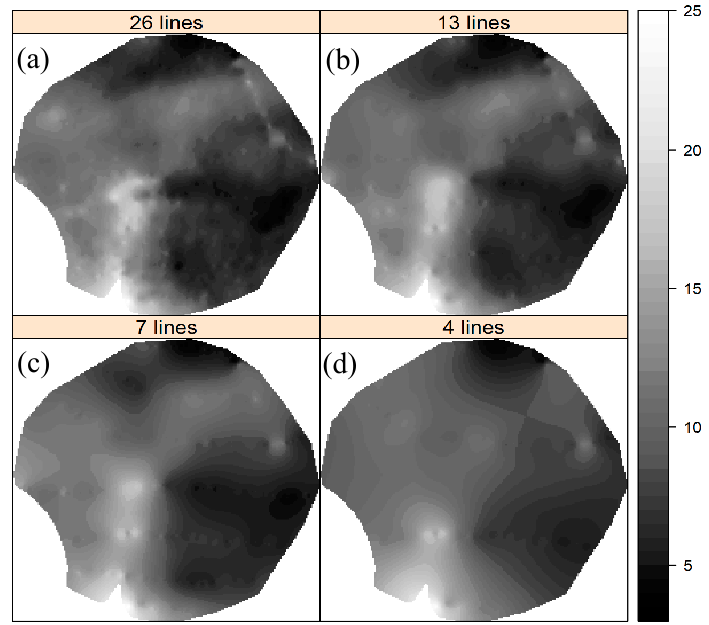
Figure 6. Soil ECa output maps from different number of lines, thus transect spacings of: 40 m ( a —26 lines); 80 m ( b —13 lines); 150 m ( c —7 lines); and 300 m ( d —4 lines).